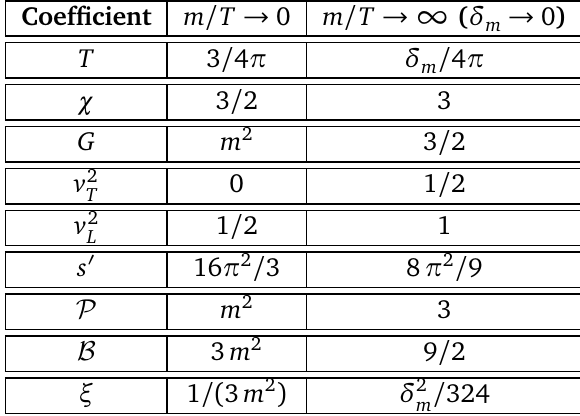
= 1 and we used the notation δ h